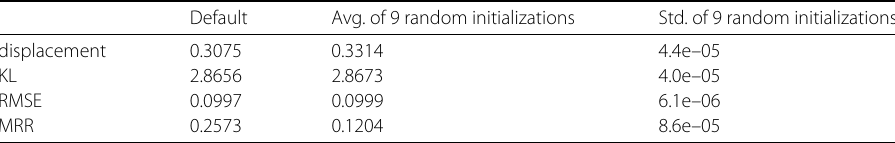
Table 2 Comparison of the default initialization strategy and alternative random initializations on the final overall evaluation metrics Default Avg. of 9 random initializations Std. of 9 random initializations